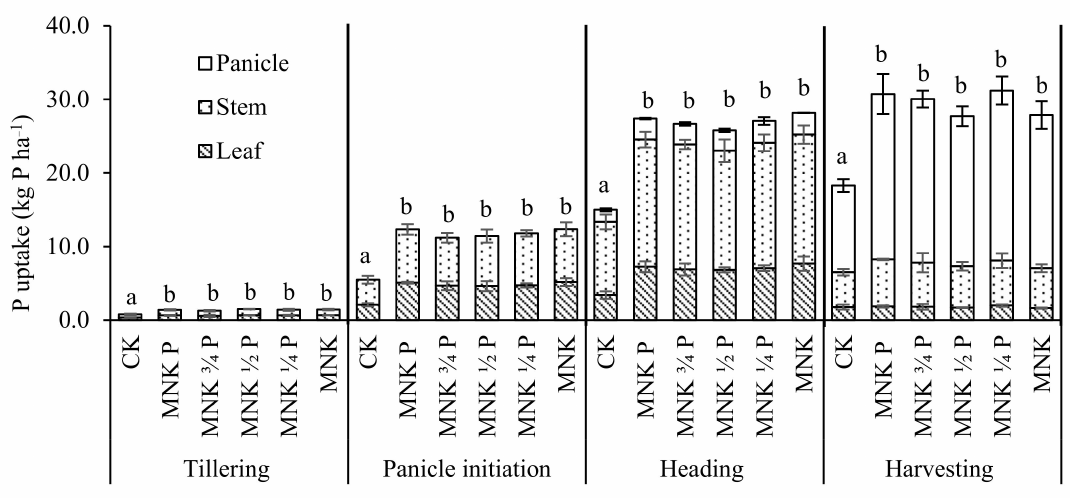
Figure 2. P uptake by rice plant and plant parts (leaf, stem, and panicle) at tillering, panicle initiation, heading, and harvesting among treatments. Bars indicate standard deviation ( n = 3). The different letters in a group indicate significant differences the using Tukey–Kramer test ( p <